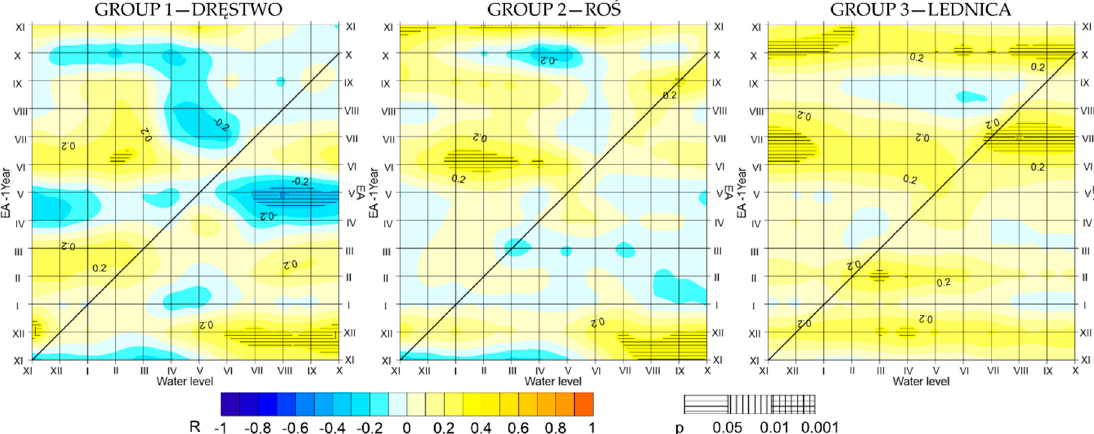
Figure 7. Matrices of coefficients of correlation for selected lakes in the designated groups (EA).